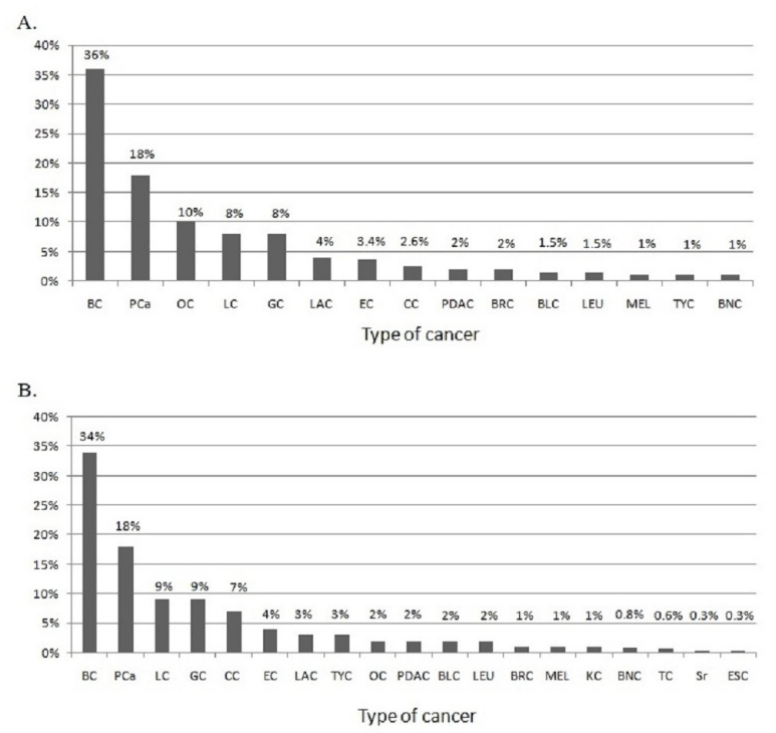
Figure 4. ( A ) Cancer types that occur in HBOC-mutated families. ( B ) Cancer types that occur in